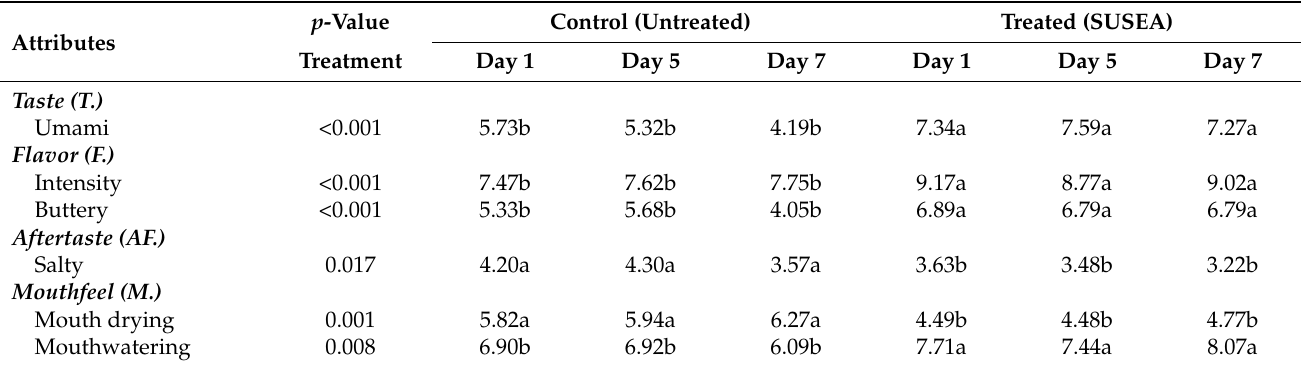
Table 3. Mean intensities (150 mm scale) of attributes varying with Treatment ( p < 0.1), according to the factorial 2-way ANOVA model (fixed factors: Treatment, Day, Interaction: Treatment*Day). Post hoc, Fischer LSD, lowercase letters indicate significant differences between treatments.